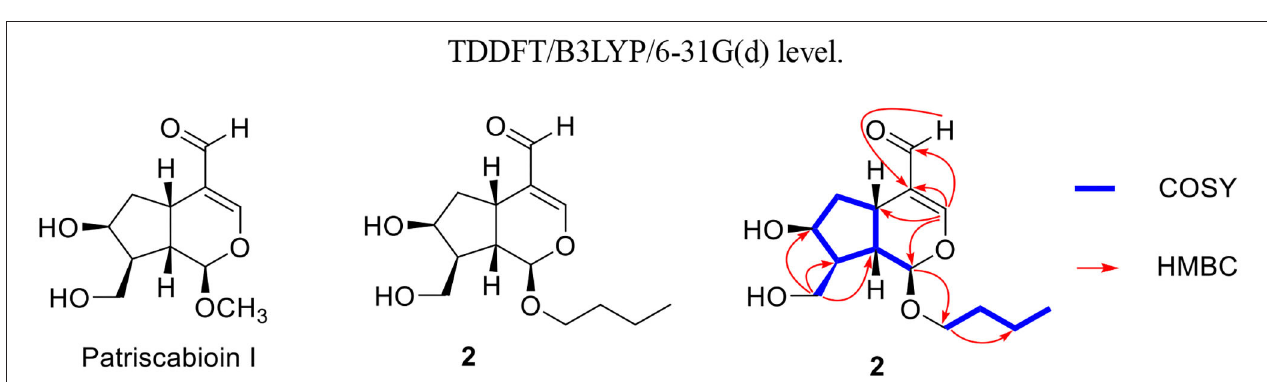
FIGURE 4 | Calculated and experimental ECD spectra of compound 1 at TDDFT/B3LYP/6-31G(d) level.